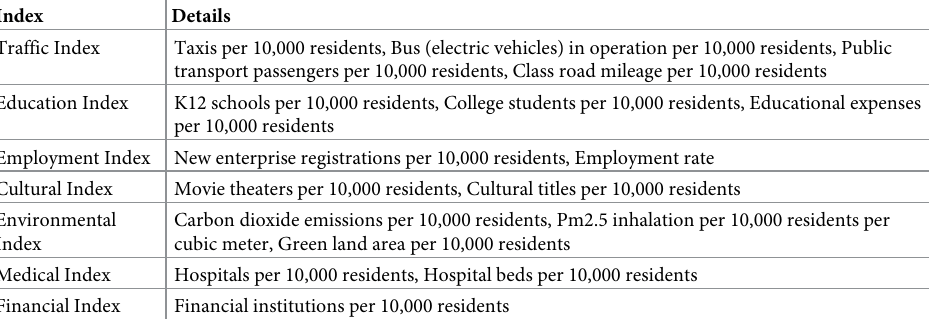
Table 3. Variable description of urban